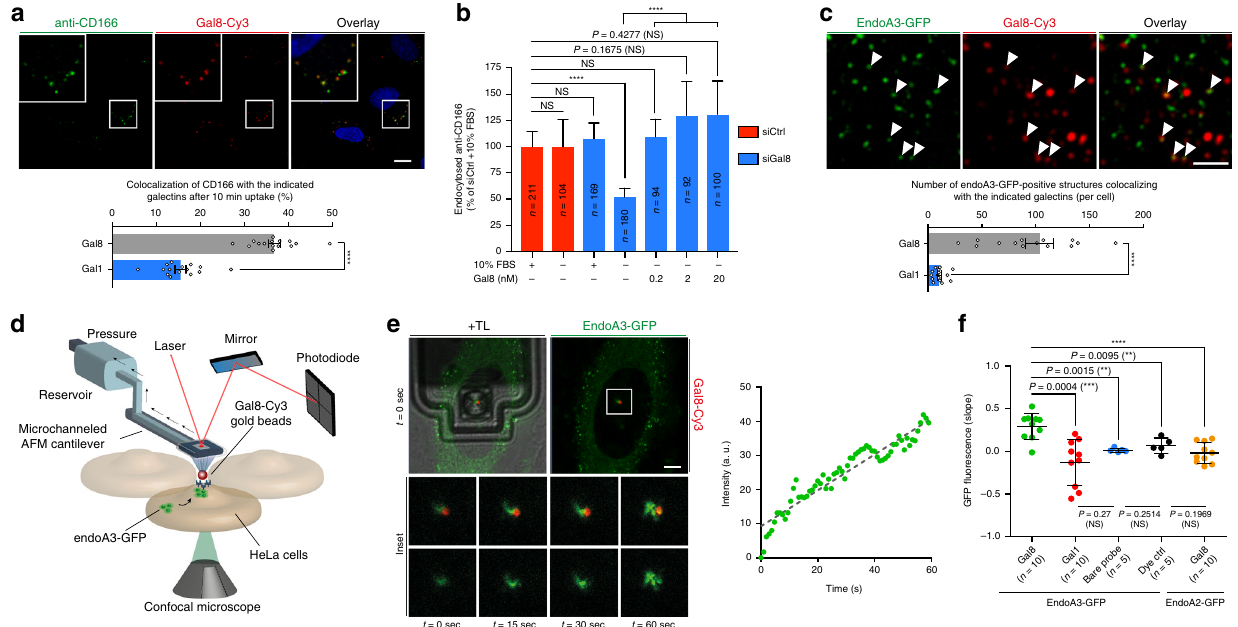
Fig. 3 Galectin-8 drives the uptake of CD166 and induces the recruitment of Endophilin-A3 to endocytic sites at the plasma membrane. HeLa cells. a Co-incubation with 5 µ g ml − 1 anti-CD166 antibody and 50 nM fl uorescent Galectin-8 (Gal8) for 10 min at 37 °C. Graph, quanti fi cations of co-localization ( n = 15 images with 5 – 15 cells per image). Three independent experiments. **** P < 0.0001 (two-tailed unpaired t test with equal variances). Galectin-1 (Gal1) condition, Supplementary Fig. 9c. b Cells treated with control (siCtrl, red) or Gal8 (siGal8, blue) siRNAs incubated with 5 µ g ml − 1 anti-CD166 antibody for 10 min at 37 °C in various conditions (graph: ±10% FBS, ±puri fi ed Gal8). Intracellular accumulation of anti-CD166 quanti fi ed from confocal images. n cells, four independent experiments. NS not signi fi cant. **** P < 0.0001 (Kruskal – Wallis test with Dunn ’ s multiple comparison post hoc test, two- sided). c Cells stably expressing endoA3-GFP incubated with 50 nM fl uorescent Gal8 for 10 min at 37 °C. White arrows, co-localization. Graph, number of co-localization events per cell. Number of cells: Gal8, n = 35; Gal1, n = 31 cells. Three independent experiments. **** P < 0.0001 (two-tailed unpaired t test with Welch ’ s correction). Gal1 condition, Supplementary Fig. 9f. d – f Gal8-induced recruitment of endoA3-GFP at plasma membrane. d Fluid-FM coupled to the confocal setup. Fluorescent galectin-coated gold nanoparticles trapped by microchanneled cantilever and approached to endoA3-GFP-expressing cells. Simultaneous monitoring of galectin (red) and endoA3 (green) fl uorescence by fast-scanning confocal microscopy. e Representative images of Fluid-FM/ confocal experiments (ten independent measurements). t = 0 s, initial cell exposure to Gal8. TL, transmitted light (cantilever). Insets: area surrounding the beads at the indicated time points. Graph: green fl uorescence intensity around beads versus time. Images and plots for Gal1, dye control, bare probe, and endoA2-GFP controls, respectively, Supplementary Fig. 9i – l. f Quanti fi cation of fl uorescence over time (slopes of linear regressions fi tted on intensity vs. time curves). n -independent measures. NS not signi fi cant. ** P < 0.01, *** P < 0.001 (two-tailed unpaired t tests). Scale bars, 10 µ m ( a ), 1 µ m ( c ), and 5 µ m ( e ). Data are mean ± s.e.m. ( a , c , f ) or median ± 95% CI. b Source data are provided as a Source Data fi